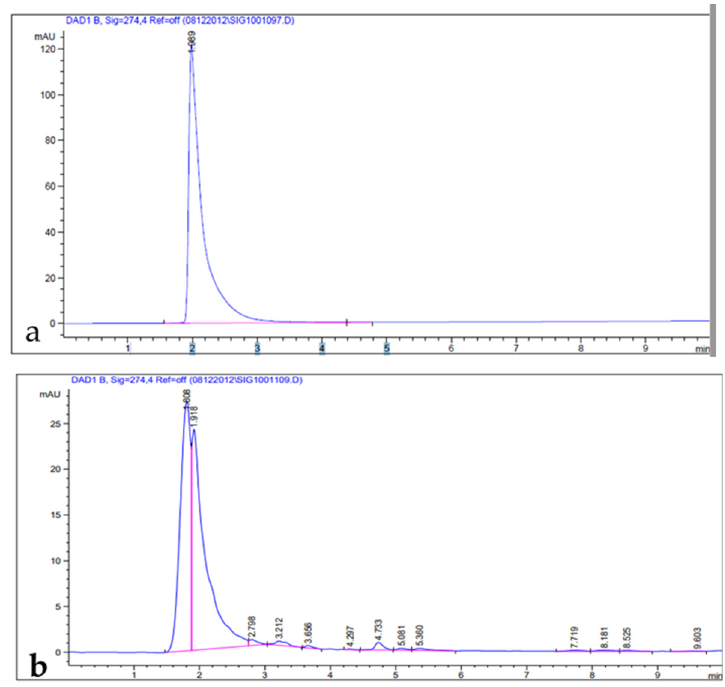
Figure 2. HPLC chromatograms: ( a ) gallic acid standard; ( b ) leaf extract.